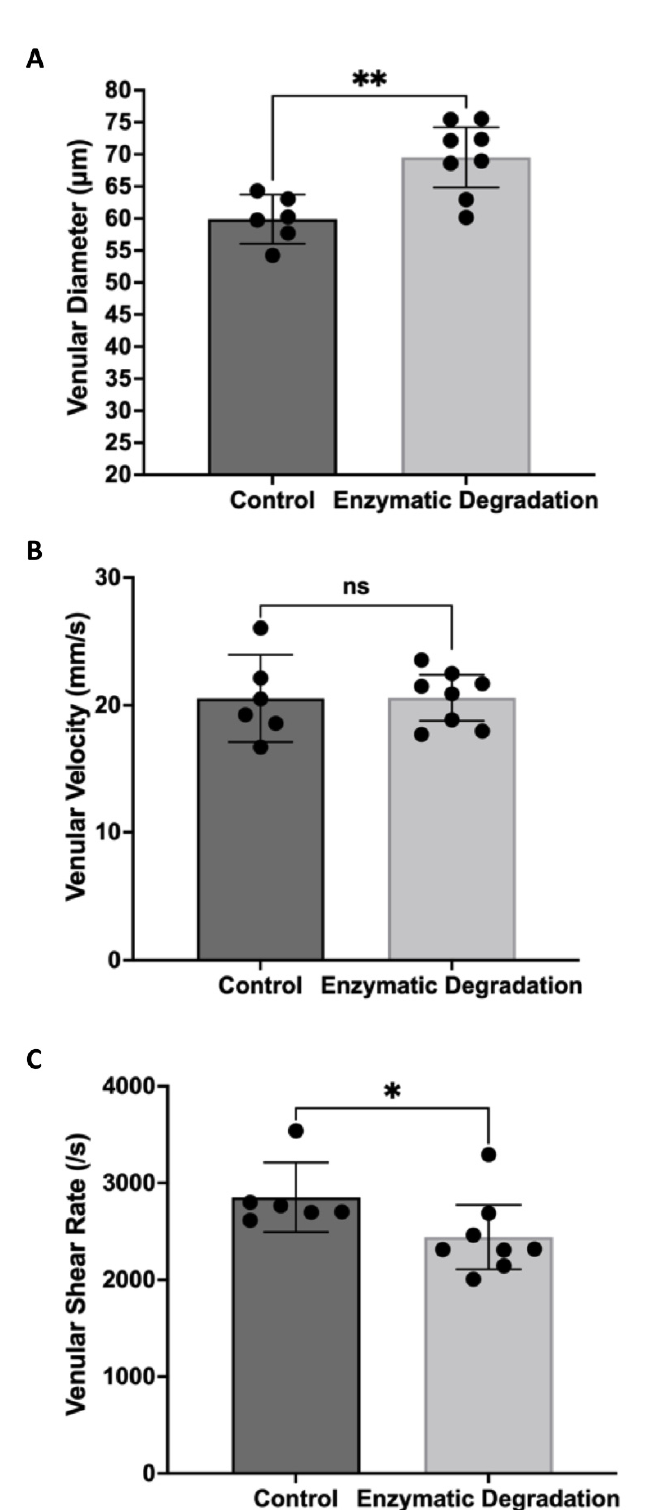
Figure 3. Retinal Venular Hemodynamics. Retinal venular diameter ( A ), velocity ( B ), and shear rate ( C ) in control mice (n = 6) and mice infused with glycocalyx-degrading enzymes (n = 8); means with 95% confidence intervals. * p < 0.05, ** p < 0.01, and ns = nonsignificant. With the shear rate proportional to velocity/diameter, the significant increase in arteriolar diameter coupled with a slight (nonsignificant) increase in arteriolar velocity did not lead to any substantial changes in arteriolar shear rate (2669 ± 430 s − 1 in